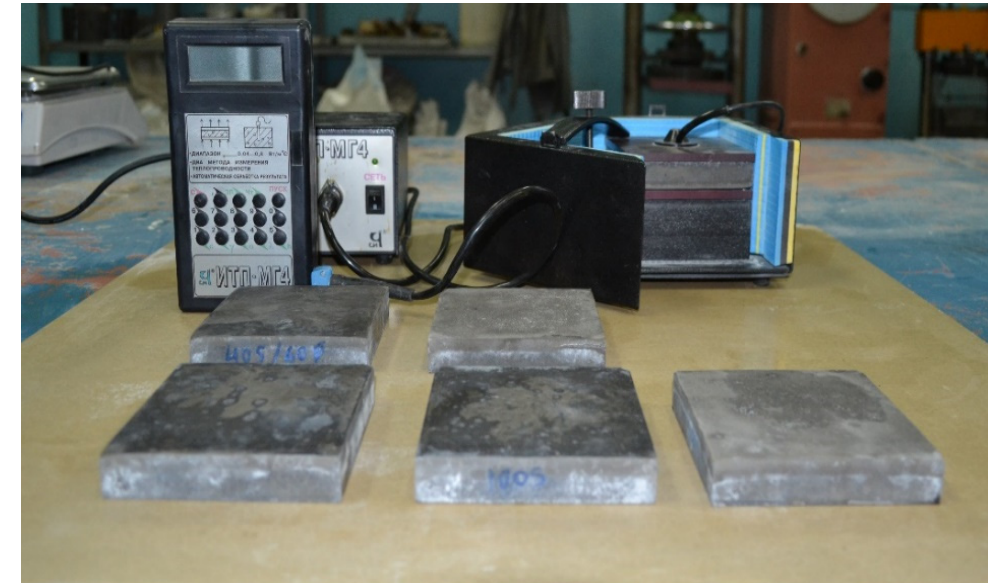
Figure 3. Measurement of thermal conductivity of aerated concrete samples.